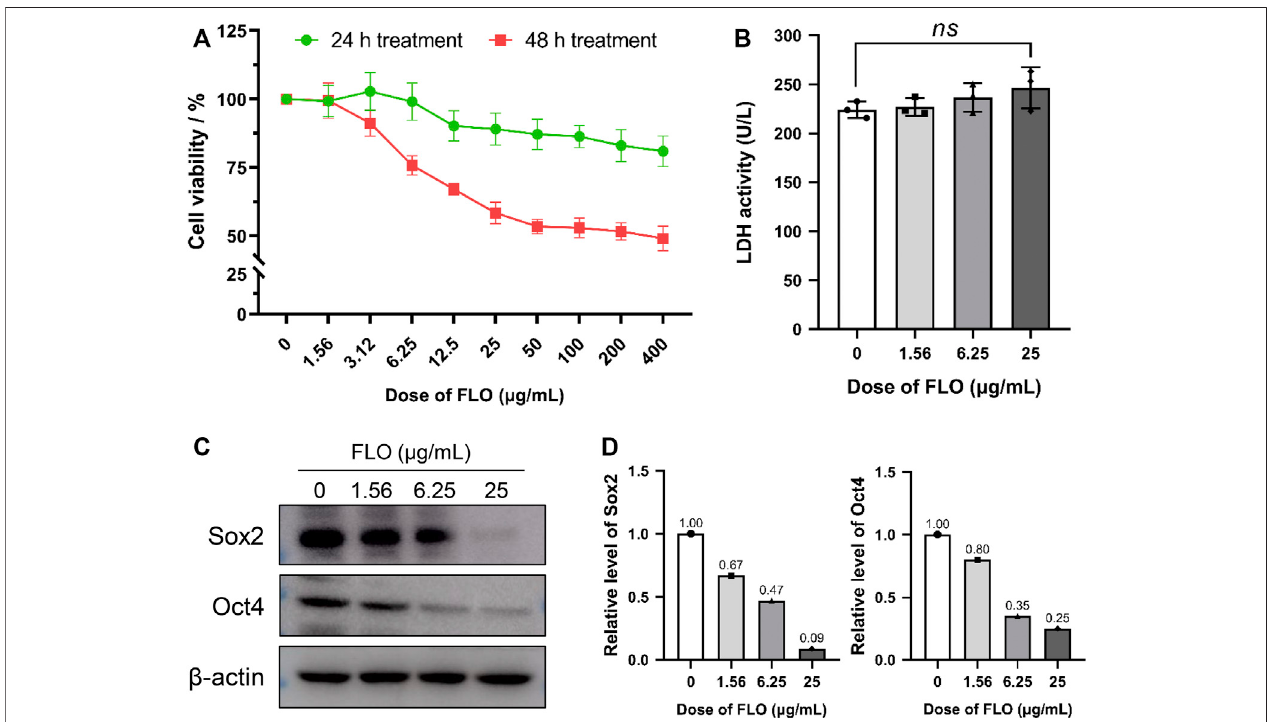
FIGURE1| FLOinhibitstheproliferationandpluripotencyofP19SCs. (A) P19SCviabilityinresponsetoFLO-treatmentasdetectedbyCCK-8method.Theresults areexpressedastheaveragecellviabilitiesfromthreeindependentexperiments. (B) EffectofdifferentdosesofFLOonLDHreleaseofP19SCswhenexposedfor48 h; ns , not signi fi cant. (C) Immunoblot analysis of multiple doses of FLO on protein levels of pluripotent markers (Sox2 and Oct4) in P19SCs treated for 48